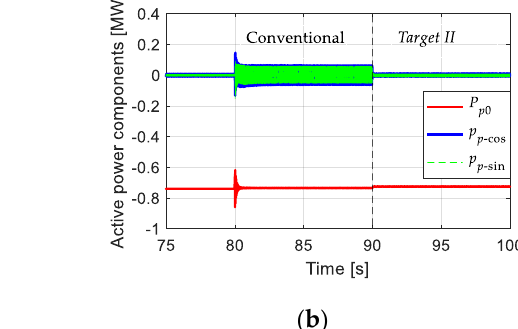
Figure 10. Simulation results comparison with Target II for primary active power ripple elimination. ( a ) Primary active power response; ( b ) Active power components.